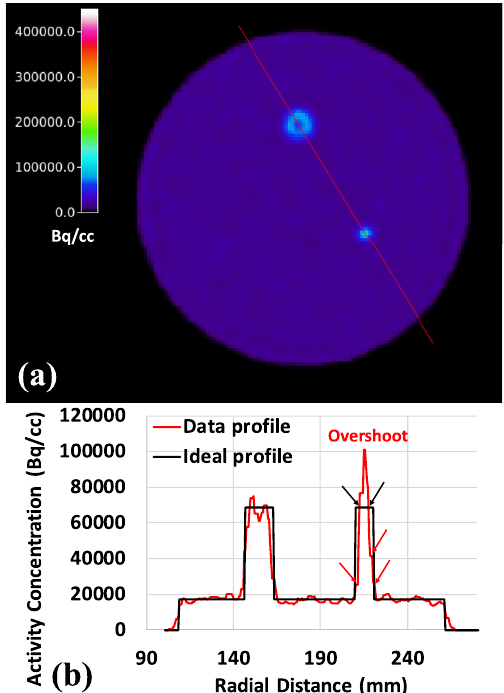
Fig. 1 Illustration of Gibb’s artifact. a The transaxial view of a contrast phantom (consisting of two spheres with 17 mm and 10 mm in diameter and a 4:1 hot‑to‑background contrast ratio) reconstructed with PSF resolution modeling; Gibb’s artifact appears as a ‘ring’ in relatively big structures (e.g. 17 mm sphere) while the ring gets pushed toward the center of the structure and forms the overshoot when the structure is small enough (e.g. 10 mm or smaller) and b the corresponding line profile as shown in ( a ) with black arrows pointing at the locations with the correct activity concentration and red arrows pointing at the locations of underestimated voxels near the edge of the structure. Note that when using a volume‑of‑interest (VOI) with the physical dimension of the 10 mm sphere, a ~ 60% contrast recovery coefficient is obtained as shown in Fig. 2 since the underestimation near the edge of the structure outweighs the overestimation near the center of the